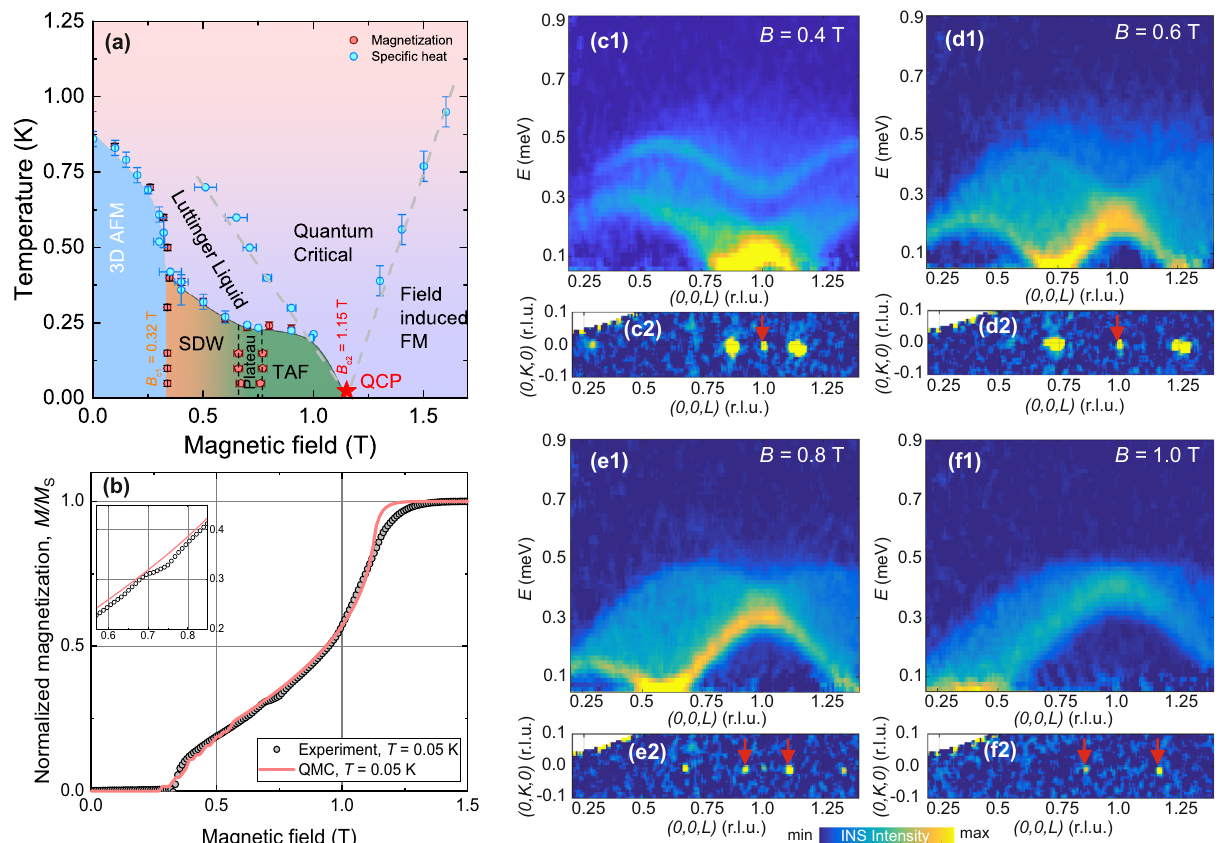
Fig. 2 Phase diagram and magnetic excitations in YbAlO 3 . a Phase diagram of YbAlO 3 reconstructed from speci fi c-heat and magnetization measurements for B ∥ [100]. Colored areas show three magnetically ordered phases; red points at low temperatures and B ≈ 0.7 T mark the position of the M fi eld-polarized regimes. Horizontal and vertical S /3 plateau. Gray dotted lines indicate crossovers between Luttinger liquid, quantum critical (QCP), and error bars correspond to uncertainties in the determination of the peak positions for constant-temperature and constant- fi eld scans, respectively. b Normalized magnetization, M / M S , measured at T = 0.05 K, and magnetization curves calculated using (QMC). The red curve shows noisy features within the spin-density wave (SDW) phase due to fi nite-size errors in the calculations. ( c 1 – f 1) Energy-momentum cuts along the (00 L ) direction measured at T = 0.05 K and in different magnetic fi elds (shown in each panel). All spectra show no gap within the experimental resolution of 50 μ eV. Because the dispersion of magnetic excitations in YbAlO 3 has 1 D character, the data were integrated over the whole available range in the orthogonal directions ( K = [ − 2; 2] r.l.u. and H = − [0.3; 0.3] r.l.u.). ( c 2 – f 2) ENS maps within the (0 KL ) plane obtained by integrating the same dataset as in c 1 – f 1 around the elastic position, E = [ − 0.05; 0.05] meV with H = [ − 0.05; 0.05]. Red arrows indicate extrinsic Bragg re fl ections due to the presence of the twin in the sample, which is discussed in detail in Sec. (S1) of the SI. Subtraction of the 2 T data set was applied to all spectra in c 1 – f